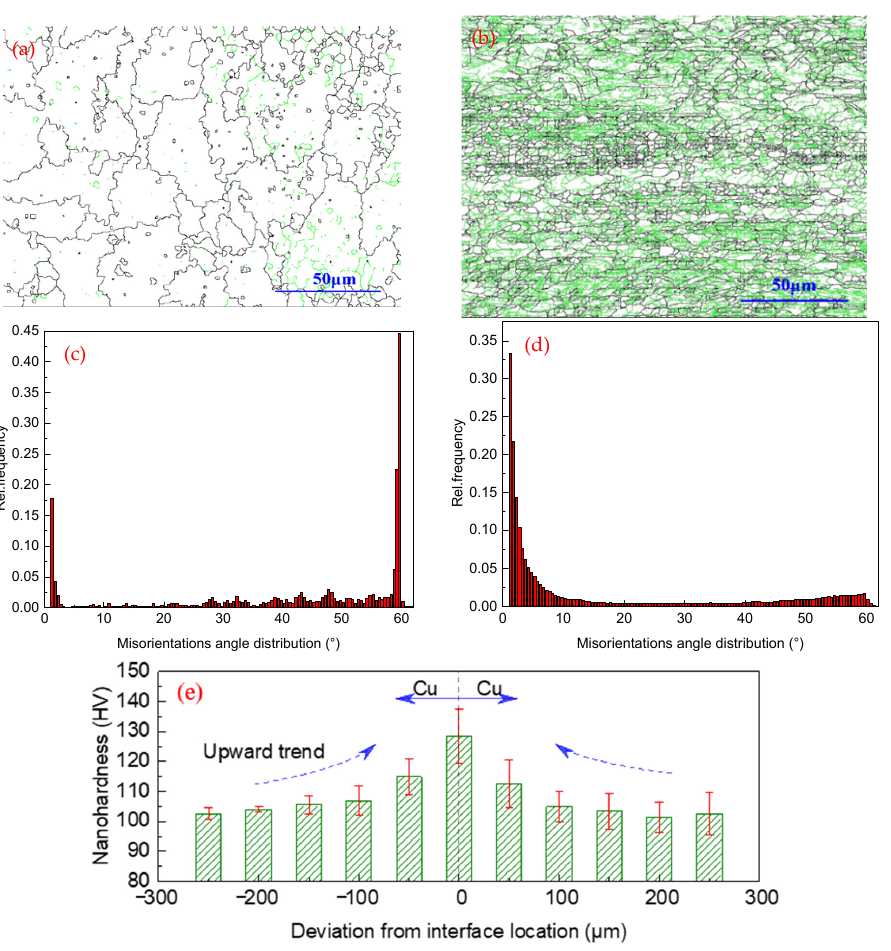
Metals 2021 , 11 , x FOR PEER REVIEW Figure 11. Grain boundary misorientation distribution map: ( a ) Cu-ETP before welding; ( b ) the welded joint at optimal process parameters combination. Fraction of grain boundary misorientation distribution: ( c ) Cu-ETP before welding; ( d ) the welded joint at optimal process parameters combination. ( e ) Nanohardness histogram of the joint.